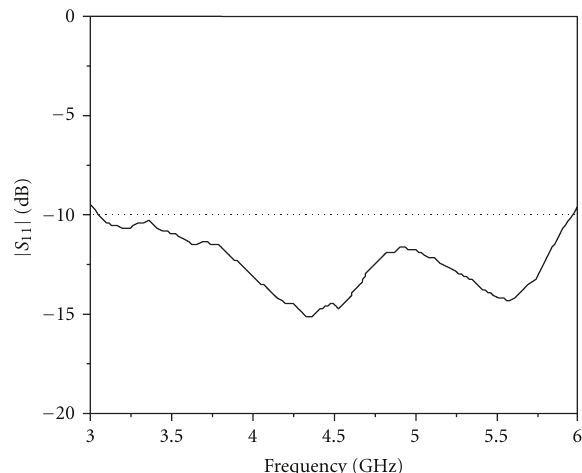
Figure 2: Measured reflection coe ffi cient of the proposed antenna.